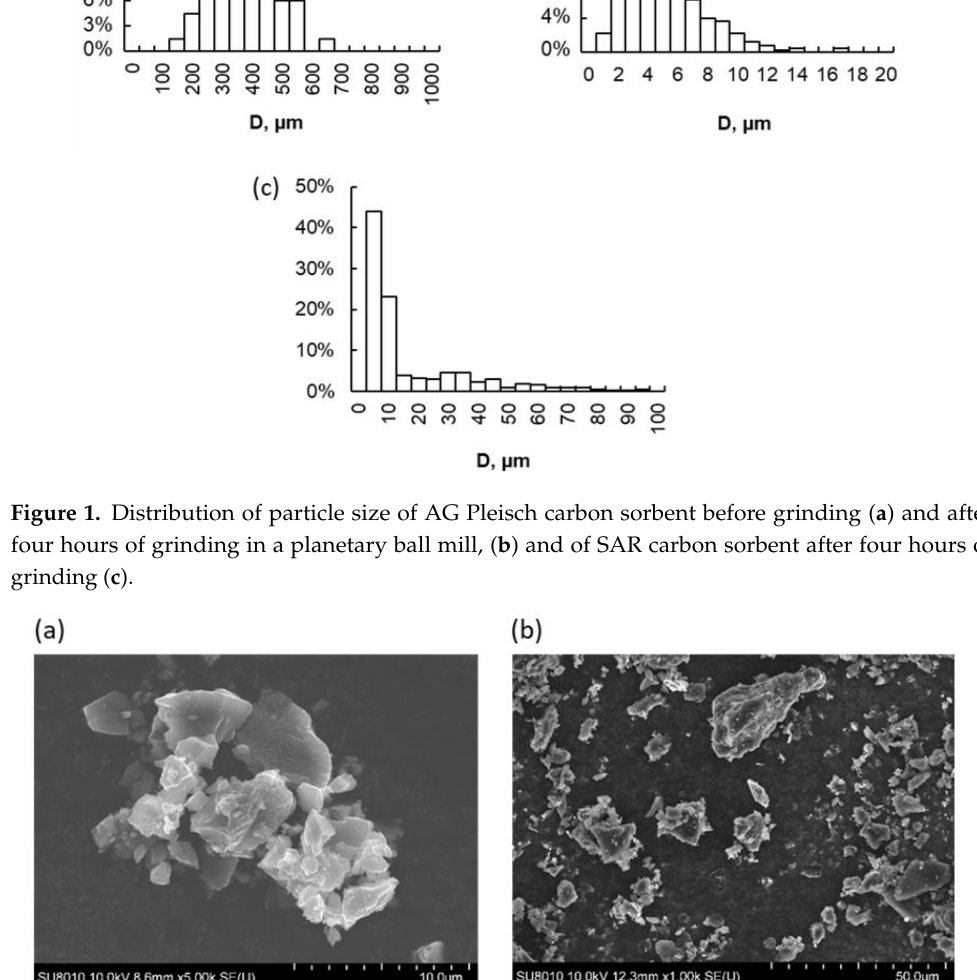
Figure 2. Images of pulverized carbon sorbent after 240 min: ( a ) AG Pleisch (×5000 magnification); ( b ) SAR (×1000 magnification).